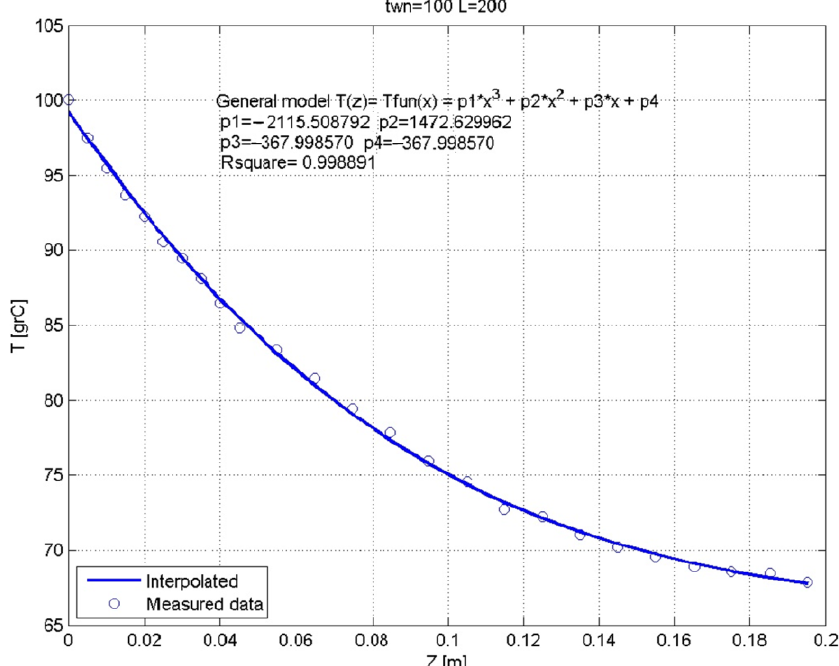
Figure 3. The third-degree polynomial approach of the experimentally measured data for t O , n = 100 ◦ C; α g = 0 ◦ ,